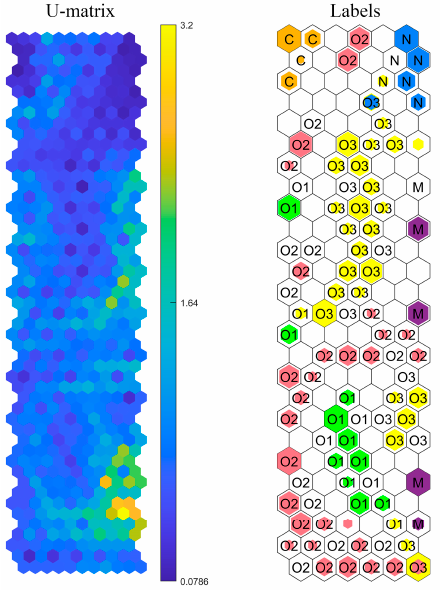
Figure 10. Illustration of training and testing results of SOM.